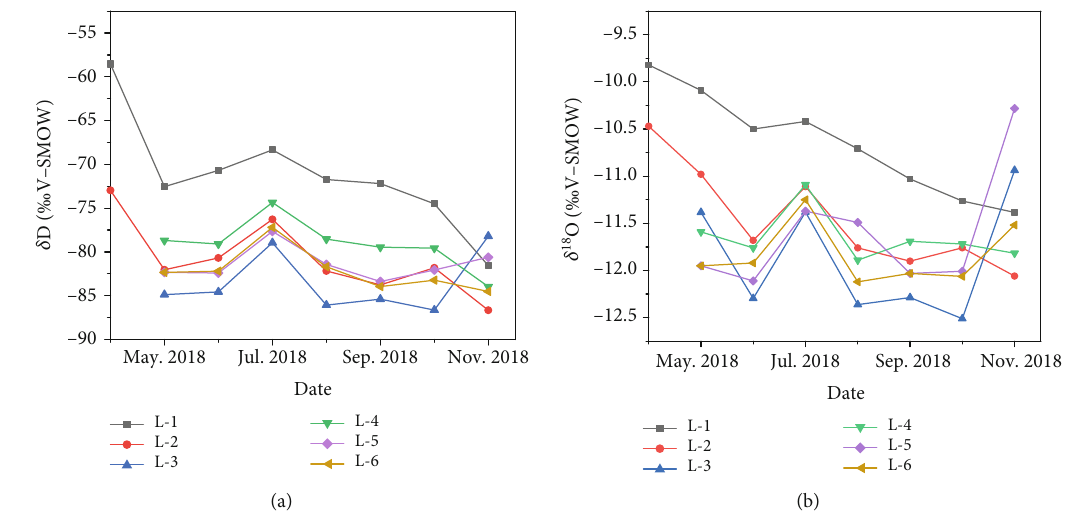
Figure 5: Variation of D and 18 O isotopes in production water with